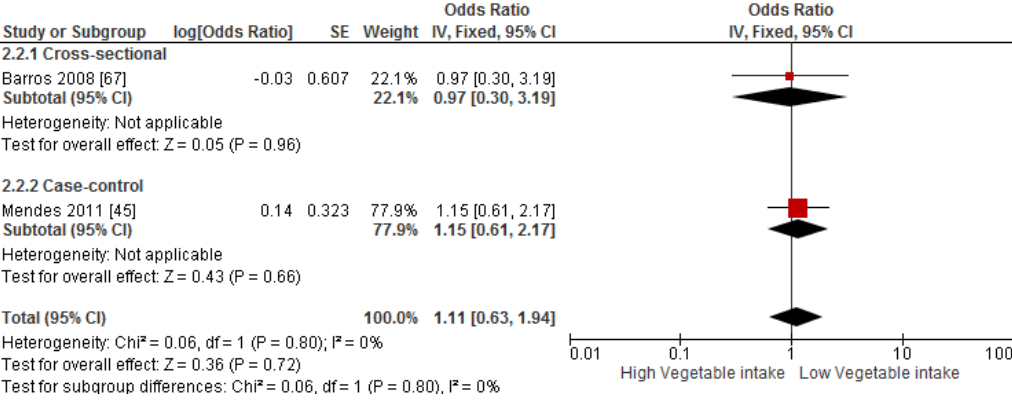
Figure 6. Meta ‐ analysis of the association between vegetable intake and severity of asthma. Figure 6. Meta-analysis of the association between vegetable intake and severity of